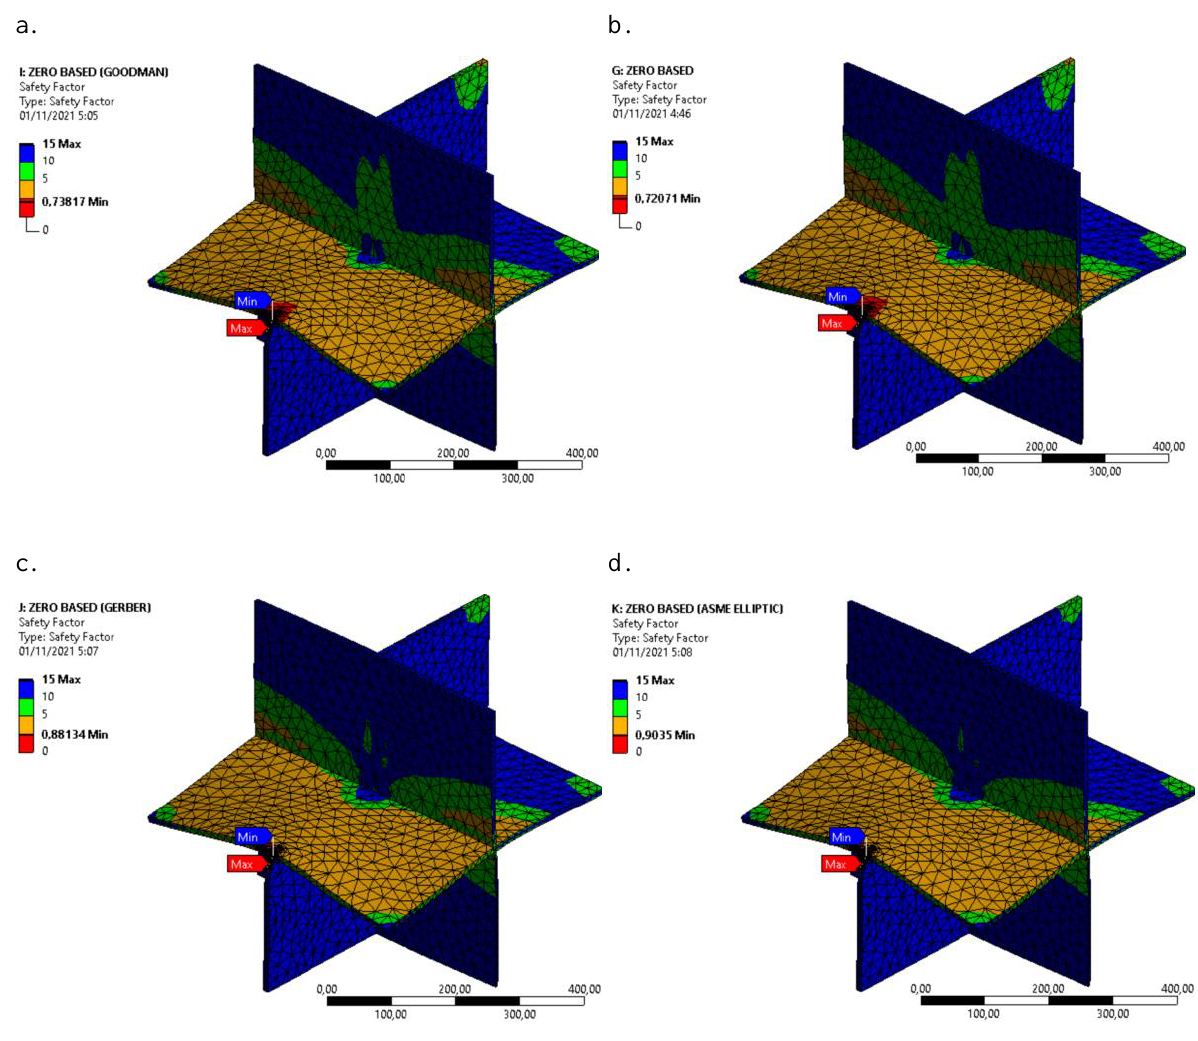
Figure 25: Safety factor using different mean stress correction theories: a. Goodman; b. Soderberg; c. Gerber; d. ASME elliptic Figure 25. Safety Factor using Different Mean Stress Correction Theories: a. Goodman; b. Soderberg; c. Gerber; d. ASME Elliptic